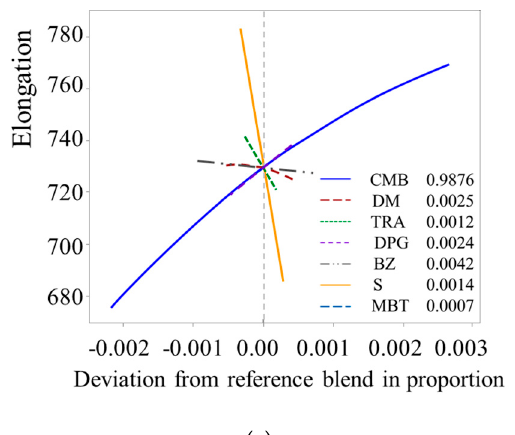
Figure 1. Cox response trace plots for mechanical properties depending on mixing ratio: ( a ) hardness; ( b ) tensile strength; ( c ) elongation.